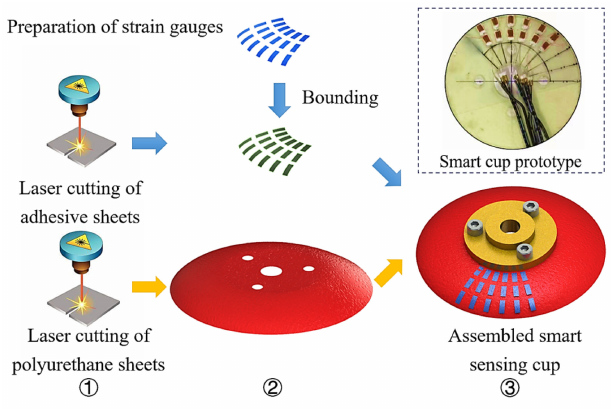
Figure 6. Fabrication procedures for the smart cup.